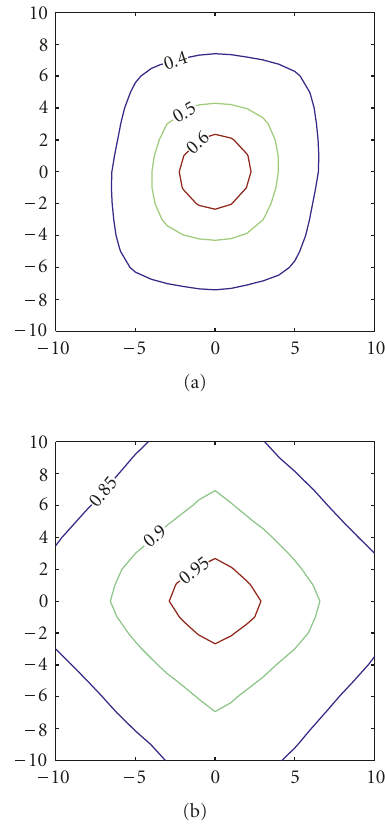
Figure 13: The contour plots of the autocorrelation functions of the (a) sar2 and (b) gold images.